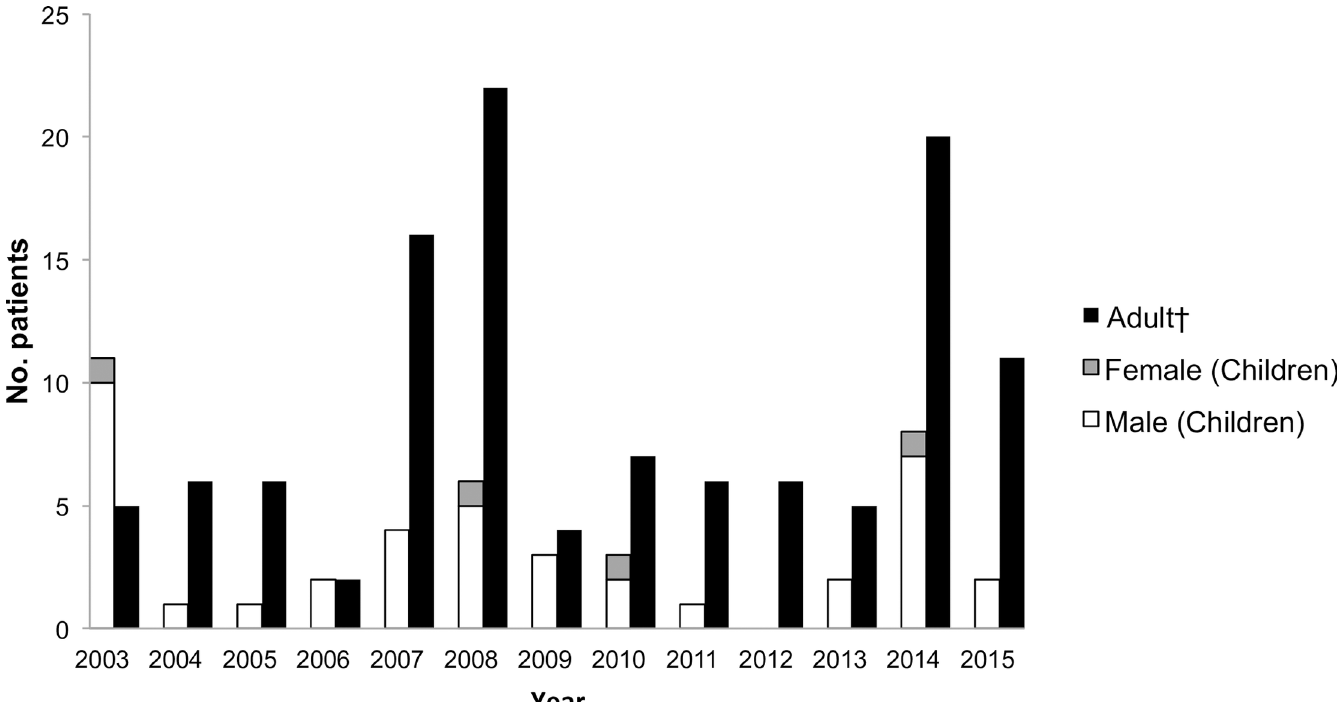
Fig 1. Annual number of cases. Adult leptospirosis cases reported in Okinawa [5] are shown for comparison.